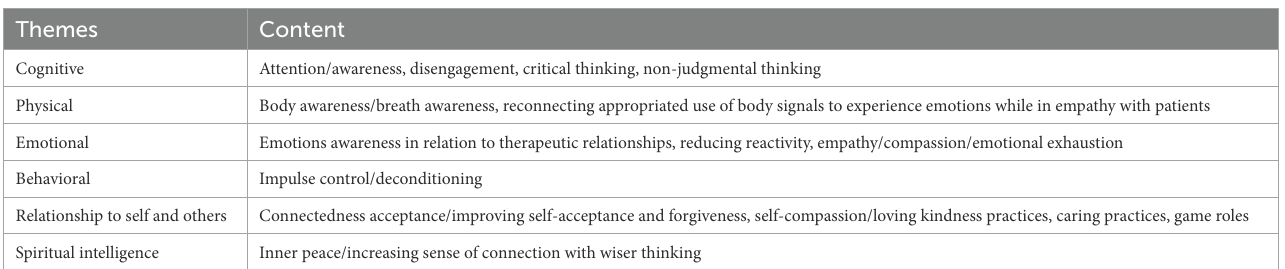
FIGURE 1 MB CARE’ curriculum.